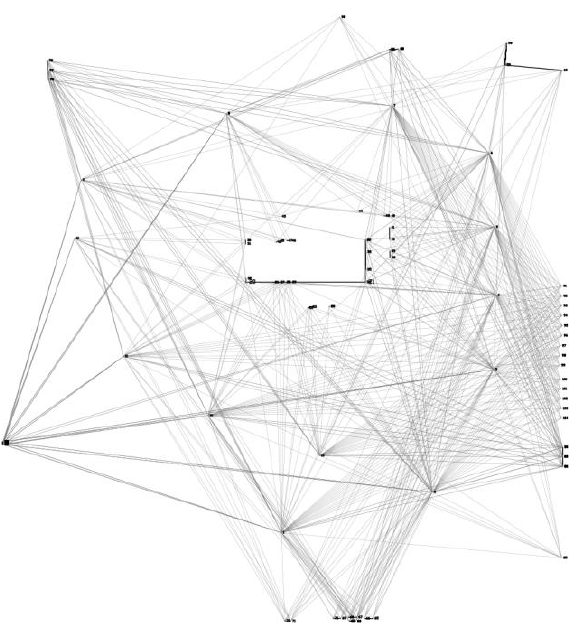
Figure 10: The exterior network of panoramas in PSP The interior network consists of seven panoramas, five of them covering almost the entire interior space and two of them covering the southern chamber detail. The interior network shown in Figure 11 and 12 was oriented using 692 observations with the following results of the block